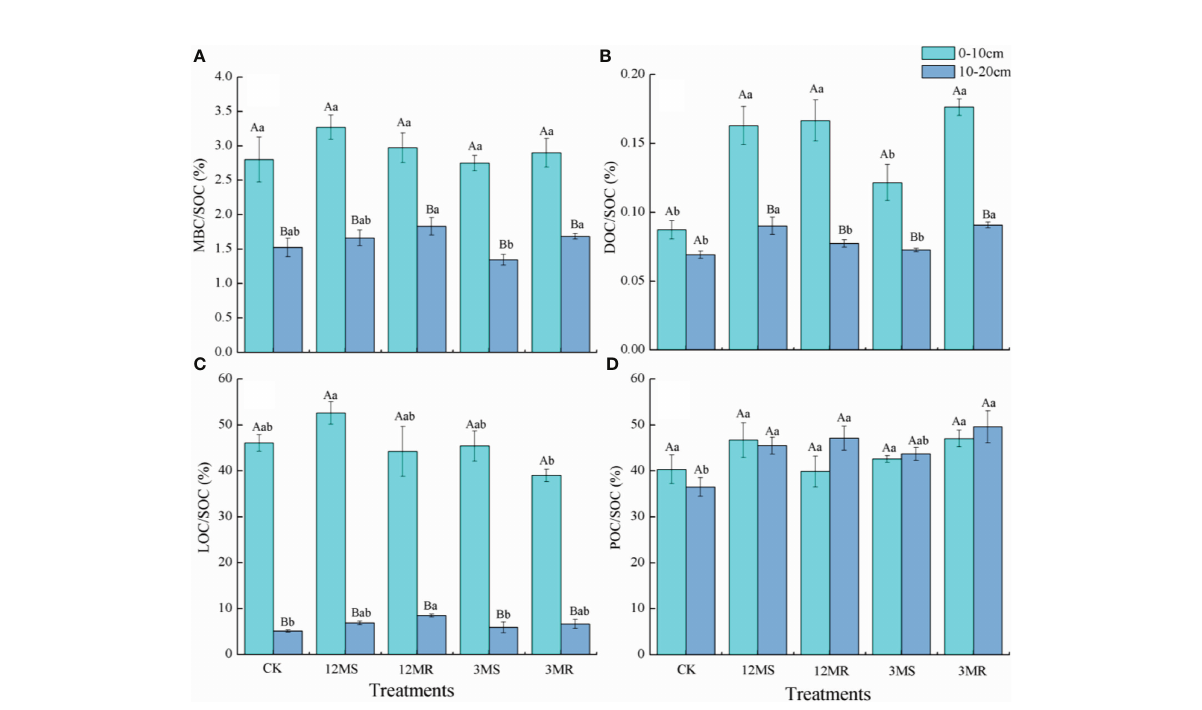
FIGURE 3 MBC/SOC (A) , DOC/SOC (B) , LOC/SOC (C) , and POC/SOC (D) under different treatments. Data are mean ± SD (n = 4). Different lowercase letters represent signi fi cant differences under different treatments. Different capital letters indicate signi fi cance between 0- to 10-cm and 10- to 20-cm soil layers of each treatment.